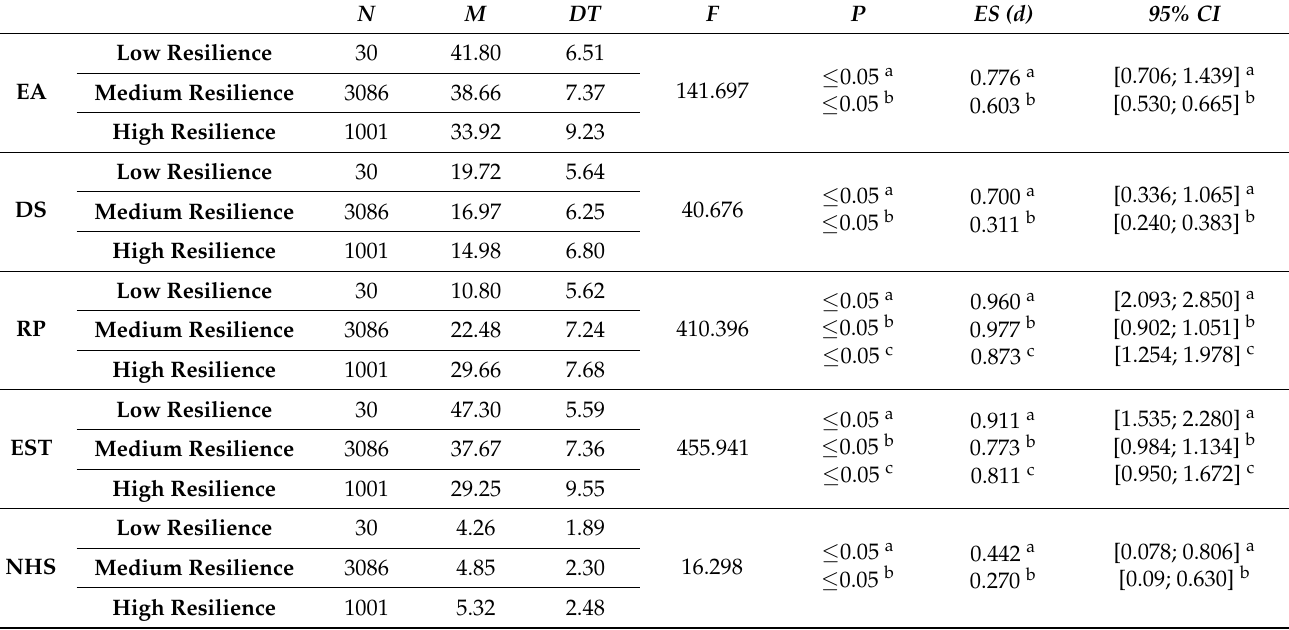
Table 2. Comparative study of the total population. N M DT F P ES